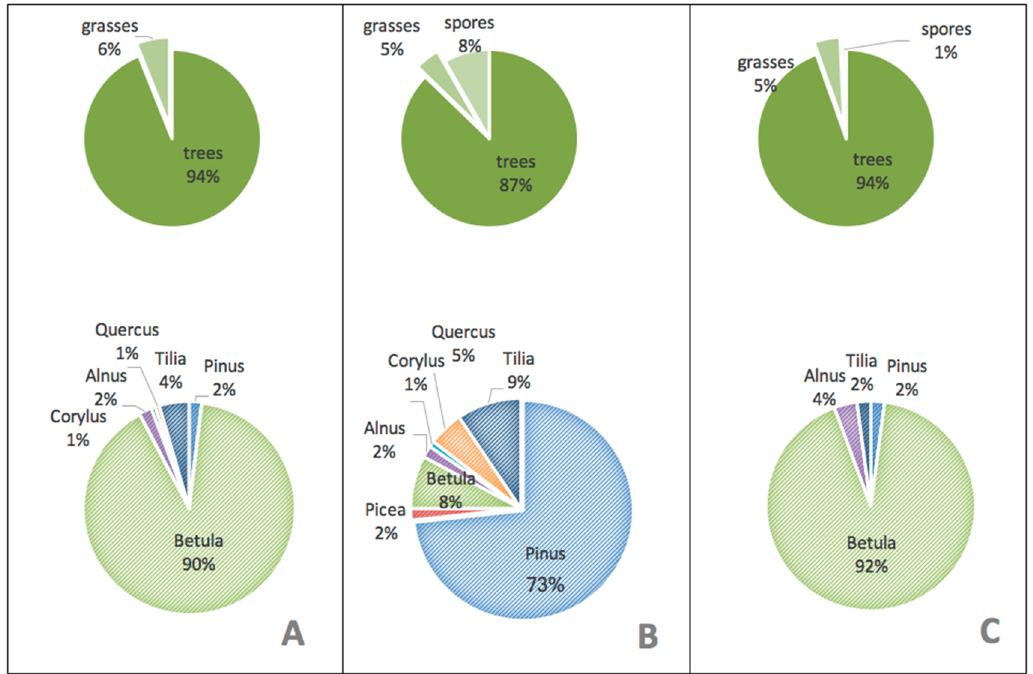
Figure 10. Total pollen and spore spectrum and the pollen spectrum of the tree and shrub species in the upper 0–5 cm layers of the surface soil ( A ) and the buried soil in its western ( B ) and northern wall ( C ). Table 7. Silica microbiomorphs and individual groups of